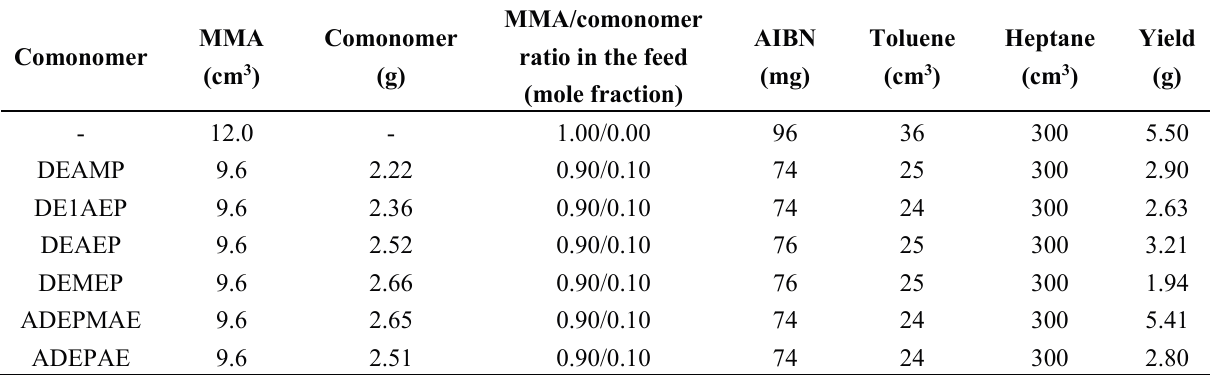
Table 2. Preparative data for methyl methacrylate (MMA)-based polymers.